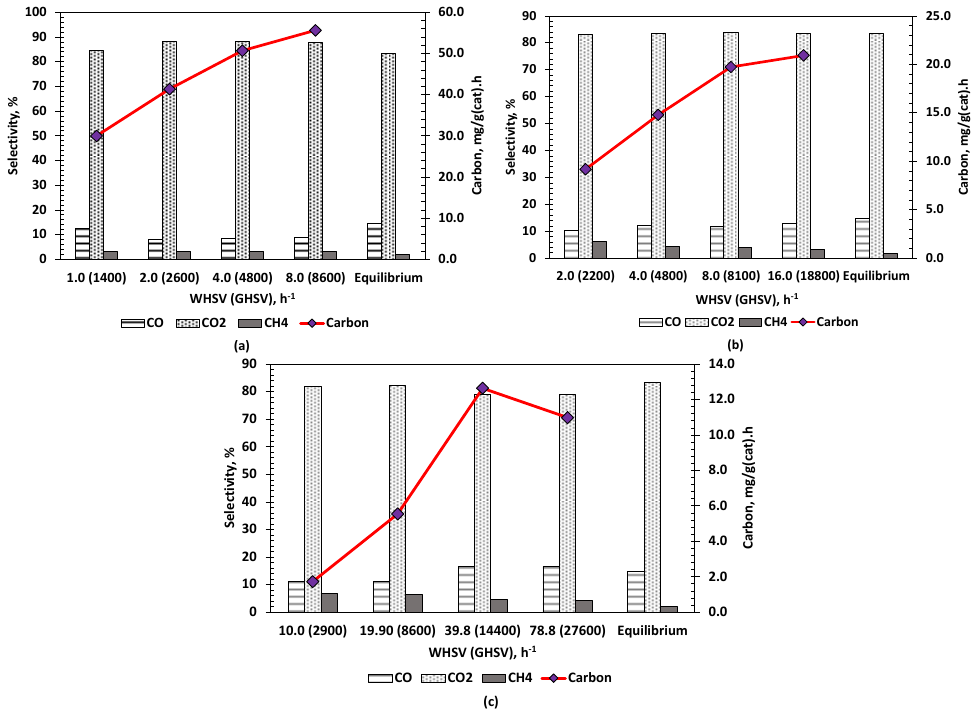
Figure 5. Effect of increasing WHSV (and GHSV), on CO, CO 2 and CH 4 selectivity or dry gas composition (%) and carbon formation (mg g(cat) − 1 h − 1 ). All flows at S/C = 2 and λ = 0.353 corresponding to a reactor exit temperature of 570 °C. ( a ) Ni-Al ( b ) Ni-CaAl ( c ) Rh-Al.